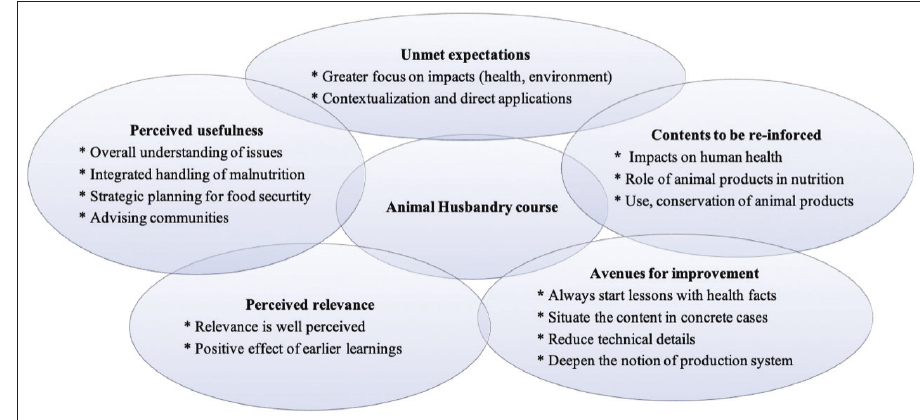
Figure-1: Learners’ major viewpoints about animal husbandry course in One Health-based